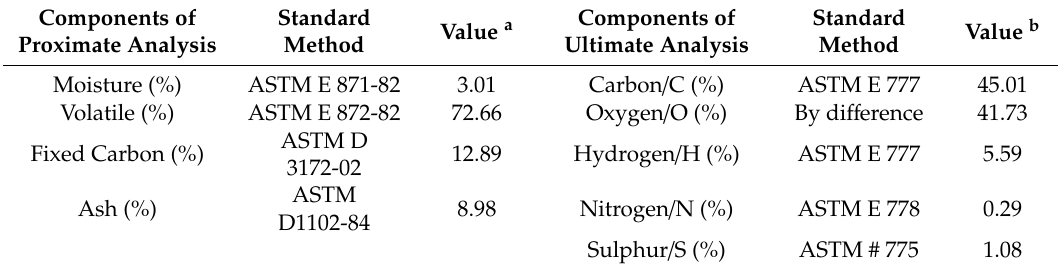
Table 1. Properties of bagasse